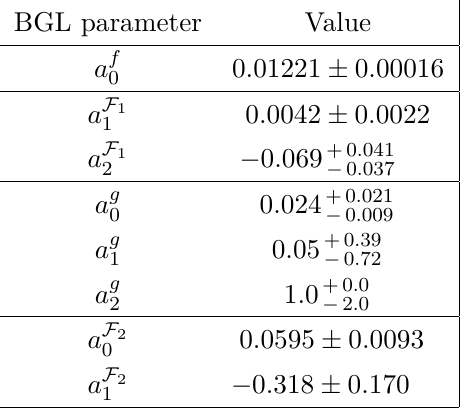
Table 8 . Fit inputs used for the BGL fit, taken from ref. [17] and ref. [24].